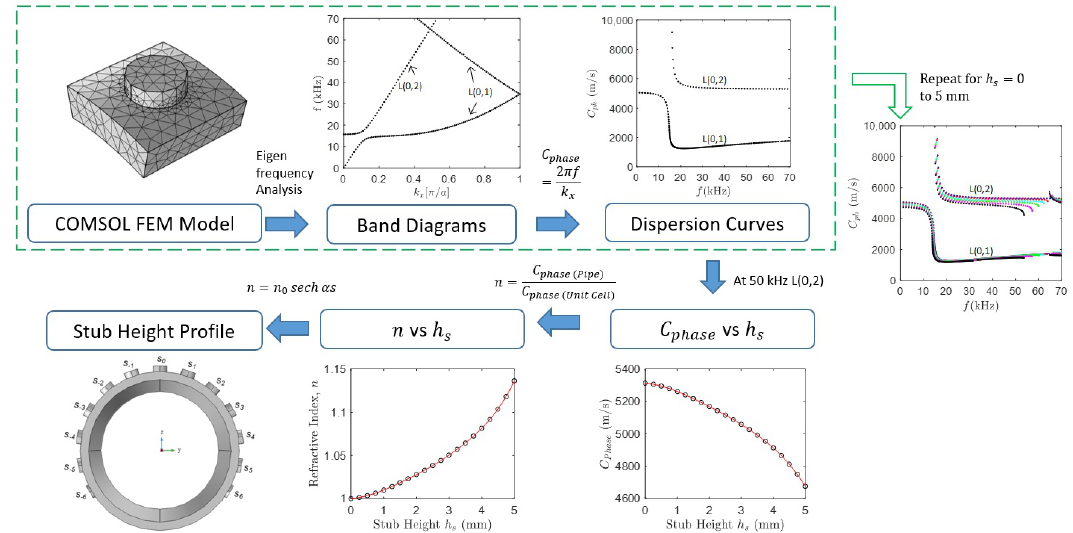
Figure 1. The flow chart of gradient-index (GRIN) phononic crystal lens design for steel pipe where n is the refractive index, h s is the stub height and C phase is the phase velocity of the propagating elastic wave mode, based on the design methodology in